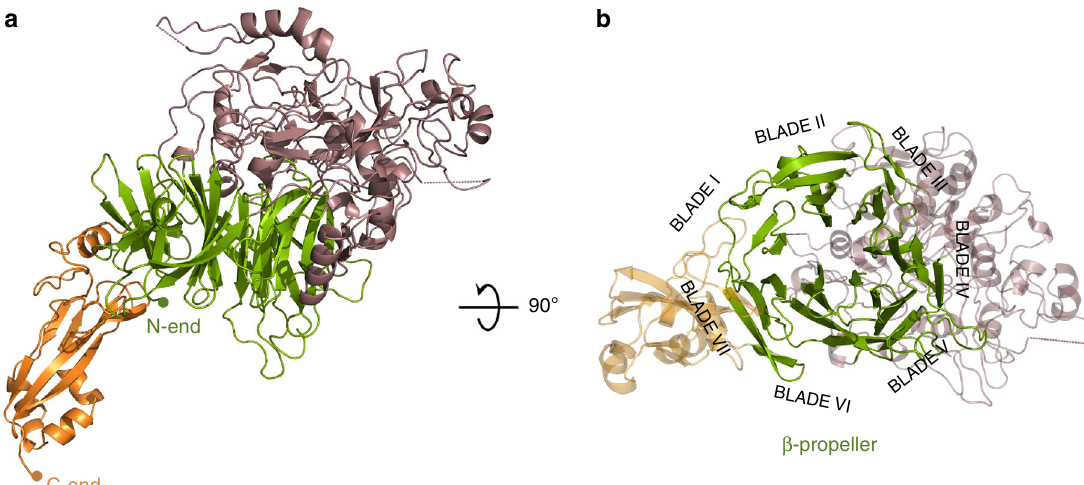
Fig. 1 Overall structure of P110. a Two views, 90° apart from each other, of the extracellular region of P110 that is formed by a large N-domain, with a seven blade β -propeller (green), the crown (brown), and the C-domain (orange). In the right side panel the view is along the central axis of the β -propeller. The situation of the seven blades in the propeller is explicitly indicated showing that the two terminal blades I and VII are close to the C-terminal domain and opposite to the